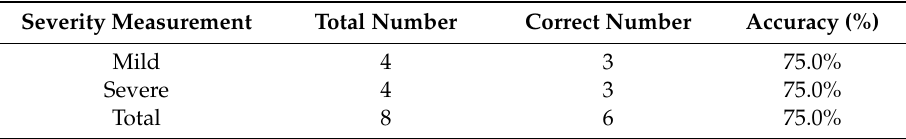
Table 4. Accuracy of severity measurement in ET patients.